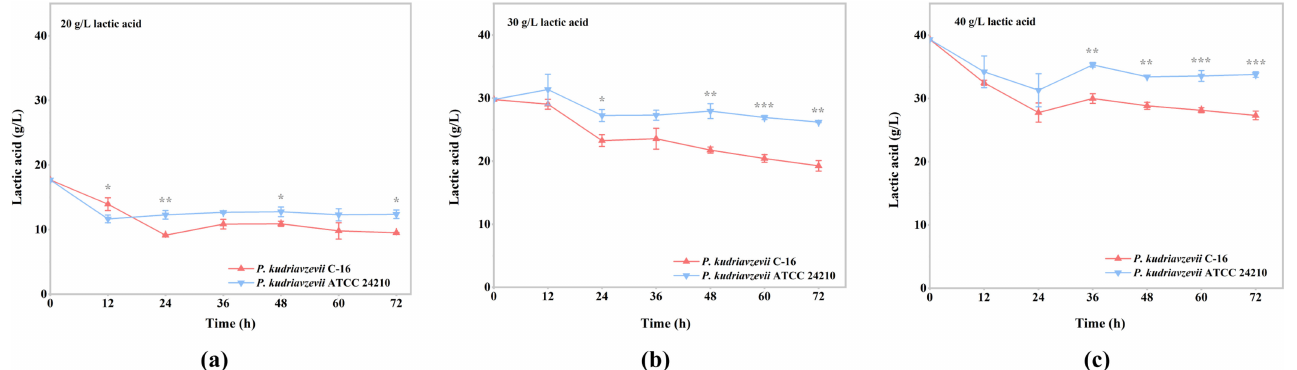
Figure 2. Lactic acid degradation performance of P. kudriavzevii C-16 and the type strain ATCC 24210 under different concentrations of lactic acid stress. ( a ) Under 20 g/L lactic acid stress; ( b ) under 30 g/L lactic acid stress; ( c ) under 40 g/L lactic acid stress. The initial pH of the culture medium was adjusted to 3.5. * p < 0.05, ** p < 0.01, *** p <